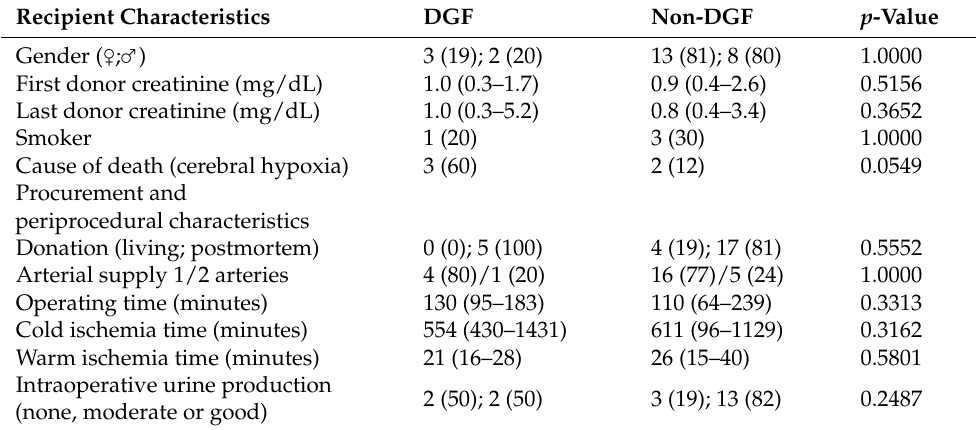
Table 3. Association between intraoperative perfusion assessment of the allograft and delayed graft function (DGF) after kidney transplantation. Quantitative perfusion assessment was performed with ICG fluorescence angiography and O2C.